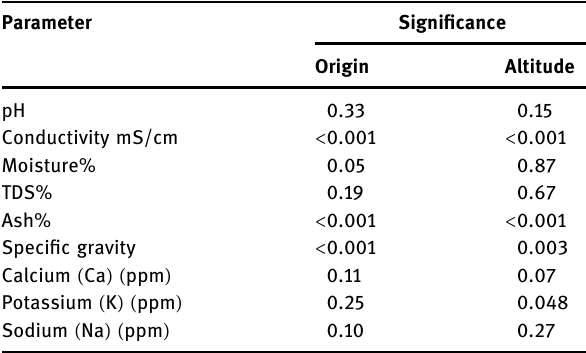
Table 3: The e ff ects of the milk animal origin and altitude on the studied parameters using the multivariate analysis